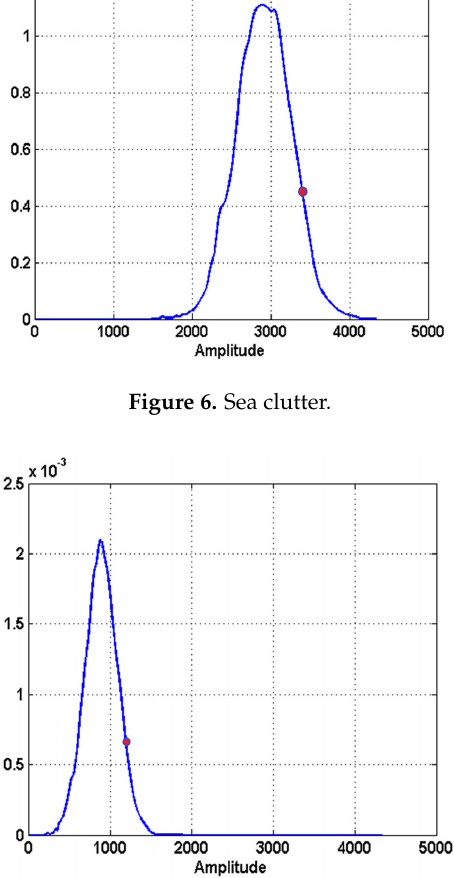
Figure 7. Oil or